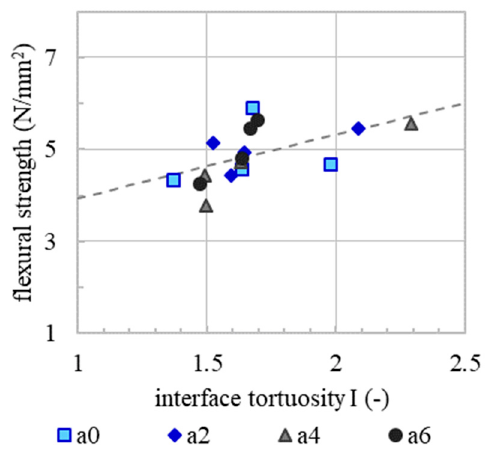
Figure 9. Linear correlation (dashed line) of mean flexural strength and mean interface tortuosity of drilling cores from the printed specimen.